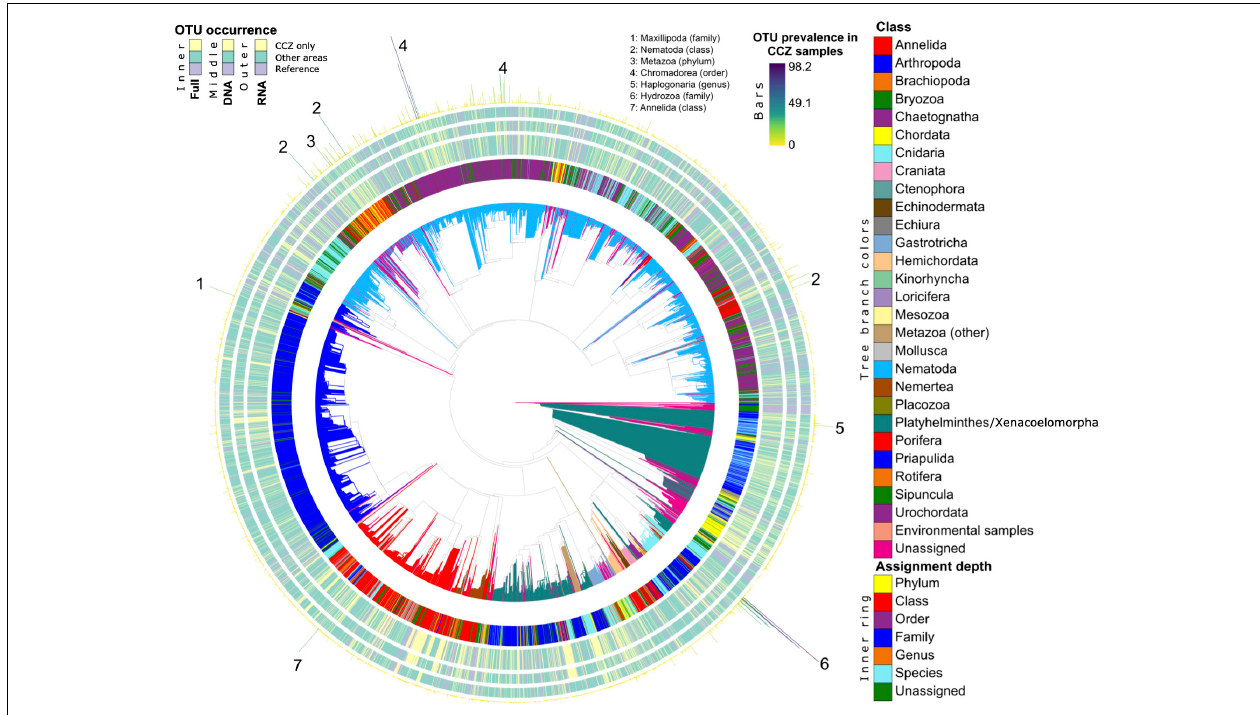
FIGURE 3 | Phylogenetic diversity and novelty of Metazoa OTUs. The phylogeny from Sinniger et al. (2016) is shown, expanded with V1V2 OTUs placements from this study. Tree branches are colored at the Class and Order levels. Concentric bar plots indicate, for each OTU its assignment depth (innermost ring), whether it is exclusive to the CCZ using both DNA and RNA (large inner ring), using DNA only (middle ring) or using RNA only (outer ring). These OTU-occurrence measures indicate whether a tip corresponds to an OTU found only in the CCZ (“CCZ only”, in yellow), to an OTU also found in any other area (“Other areas”, in turquoise), or whether a tip corresponds to a sequence from the reference phylogenies used for placement (“Reference”, in purple). The prevalence of each OTU in the CCZ samples is indicated in terms of percent of samples where it is detected in this area (outermost bars). The finest taxonomy of OTUs highly prevalent in the CCZ are